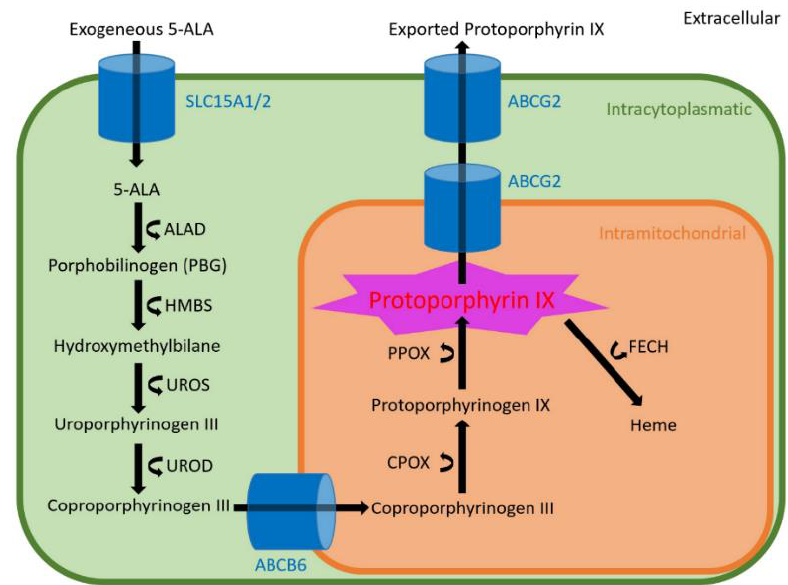
Figure 1. Schematic visualization of the heme biosynthesis pathway with all involved metabolites, transporters (blue) and enzymes (curved arrows).